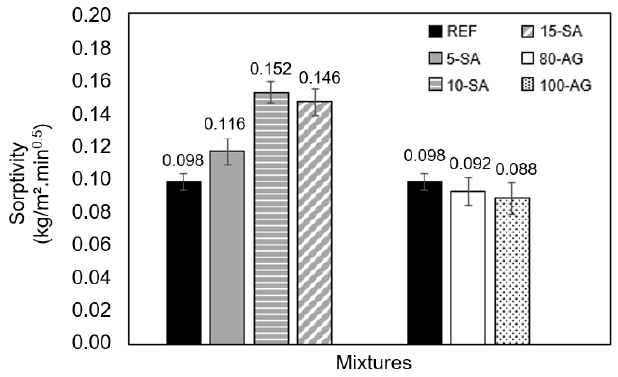
Figure 8. Sorptivity of the studied